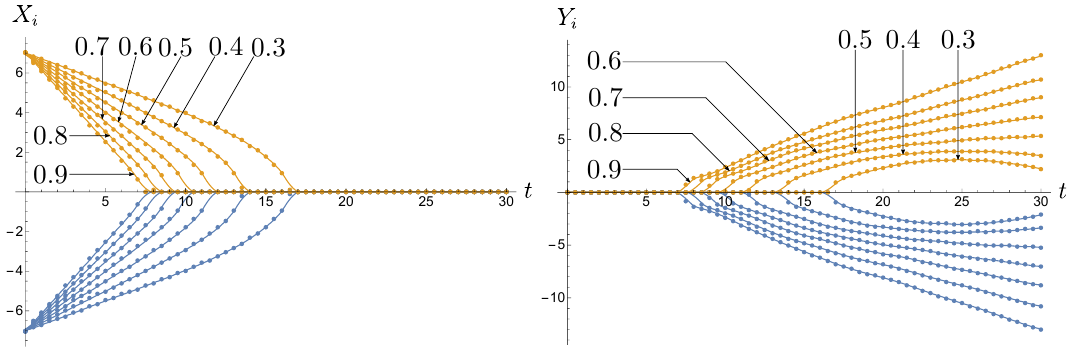
Figure 33 . Trajectories X i ( t ) and Y i ( t ) of two orthogonal non-Abelian vortices of type I*, for initial velocities u = 0 . 3 , 0 . 4 , · · · , 0 . 9 (marked on the plots for clarity).